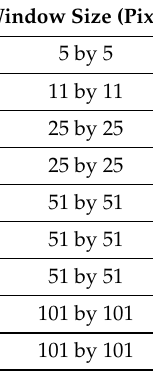
Table 2. GLCM measures.